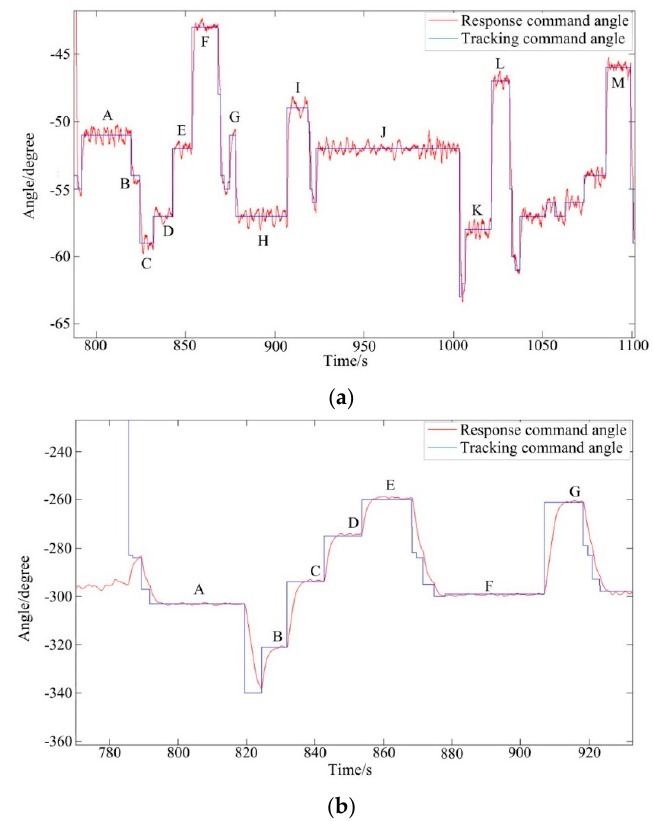
Figure 20. The tracking results of angle position of the real UH-based APLI system in air: ( a ) the pitch system; ( b ) the azimuth system. Table 1. Steady state RMS errors of each tracking angle for pitch gimbal.